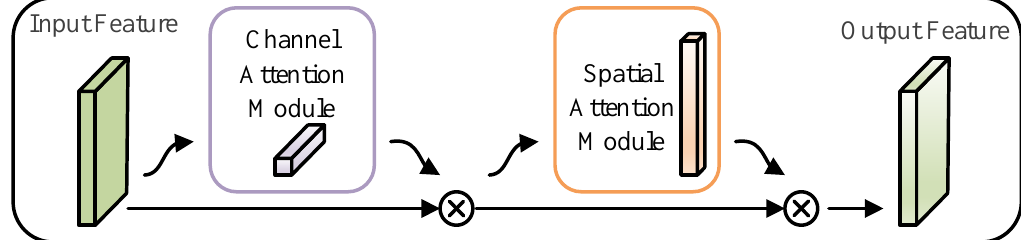
Figure 2. Structure of the CBAM.